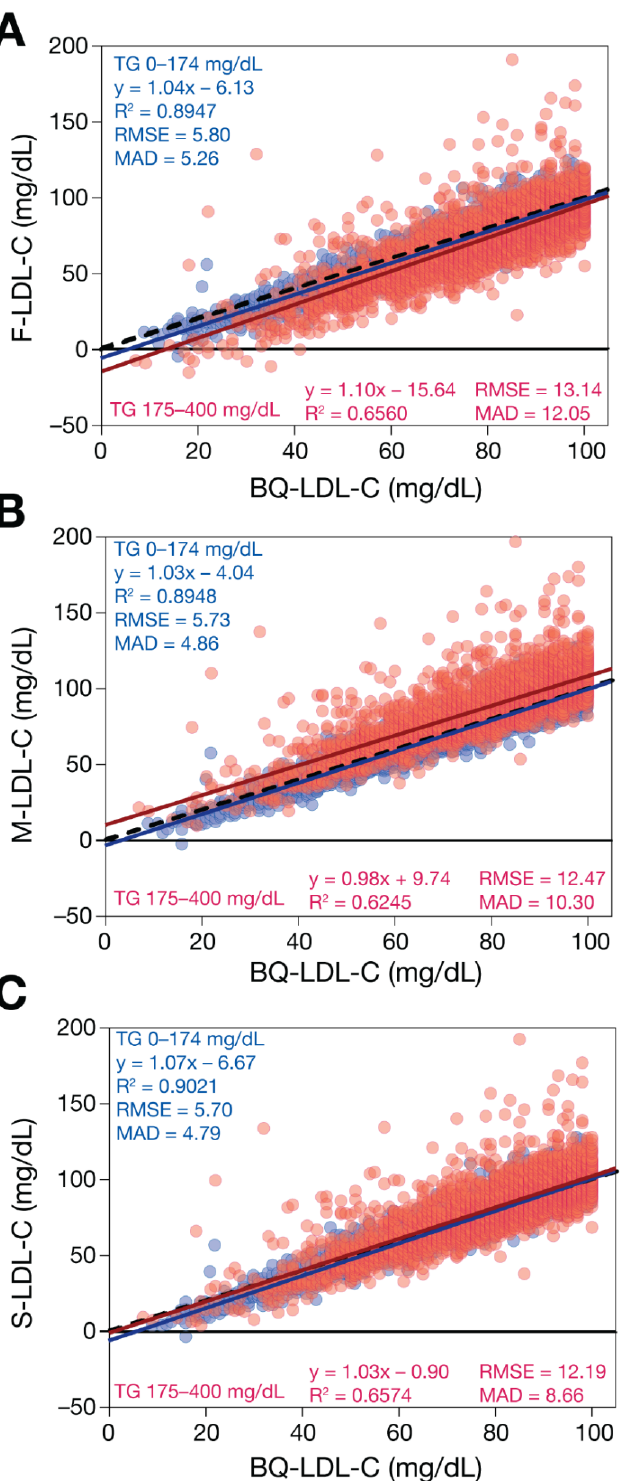
Figure 4. Comparison of estimated LDL-C versus BQ-LDL-C for low TG samples with low LDL-C. LDL-C was calculated for patients (N = 13,415) with LDL-C < 100 mg/dL and TG < 400 mg/dL values by F-LDL-C (Panel A ), M-LDL-C (Panel B ), and S-LDL-C (Panel C ) equations and plotted against LDL-C as measured by the BQ reference method (BQ-LDL-C). Solid lines are the linear fits for the indicated regression equations. Dotted lines are lines of identity. Results are color coded by TG level with TG < 175 mg/dL indicated in blue and samples with TG between 175 and 400 mg/dL in